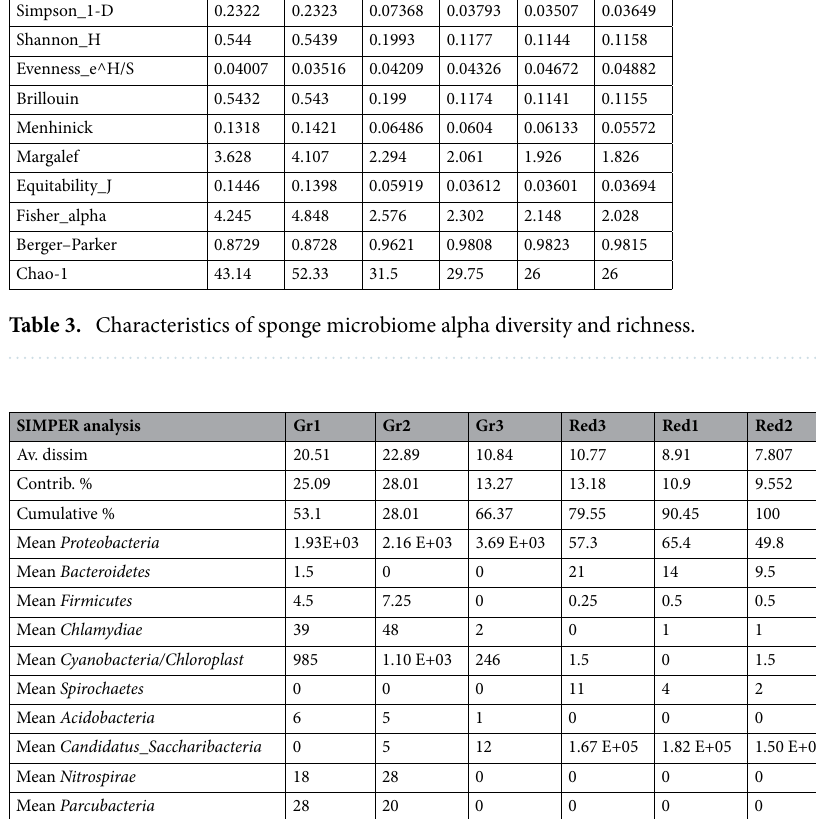
Table 4. SIMPER analysis (Bray–Curtis model). Mean percentage abundance values of Gelliodes pumila sample (Gr 1, 2 and 3; 22, 20 and 10% dissimilarity, respectively) and Cliona lobata samples (Red 1, 2 and 3 shows 10, 8 and 7% dissimilarity, respectively) contributing to differences in each of the samples.